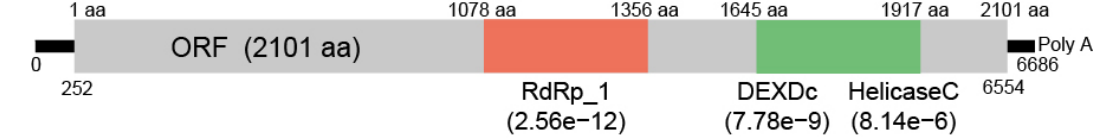
Figure 2. The genome structure of PuRV1. The boxed region shows an open reading frame (ORF). The red and green colored boxes show predicted RdRp_1 and Helicase domains, respectively.